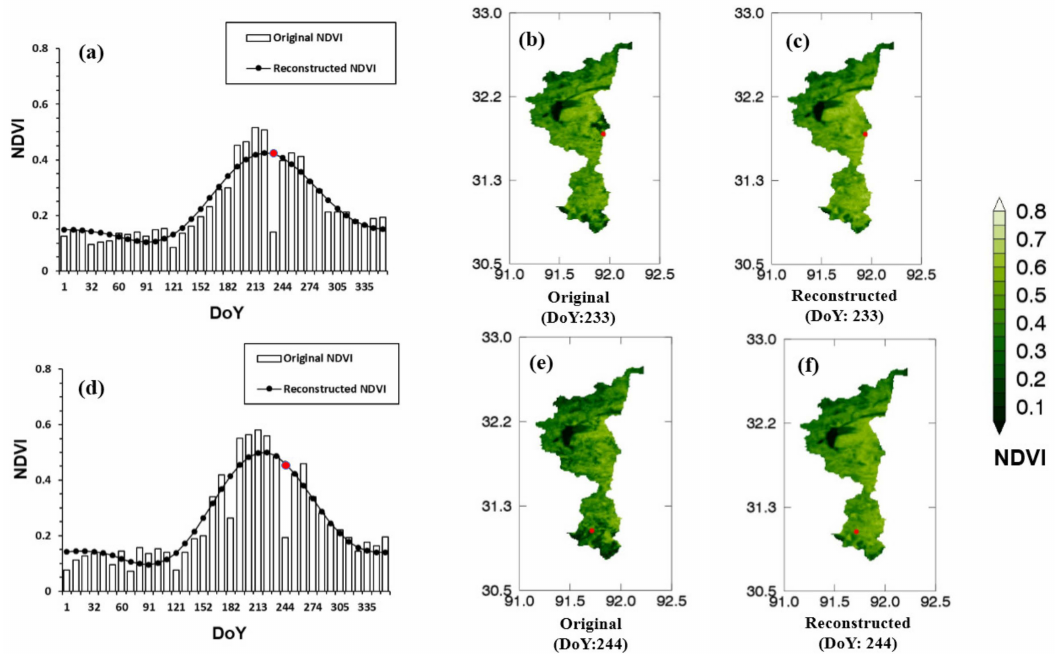
Figure 2. Comparison between NDVI before and after harmonic analysis with HANTS for pixels with cloud cover. Red points show the exact locations of the two cases. ( a , d ) are seasonal variations of original and reconstructed NDVI for the two pixels. ( b , c ) show the spatial distribution of original and reconstructed NDVI on DOY 233. ( e , f ) show spatial distribution of original and reconstructed NDVI on DOY 244.